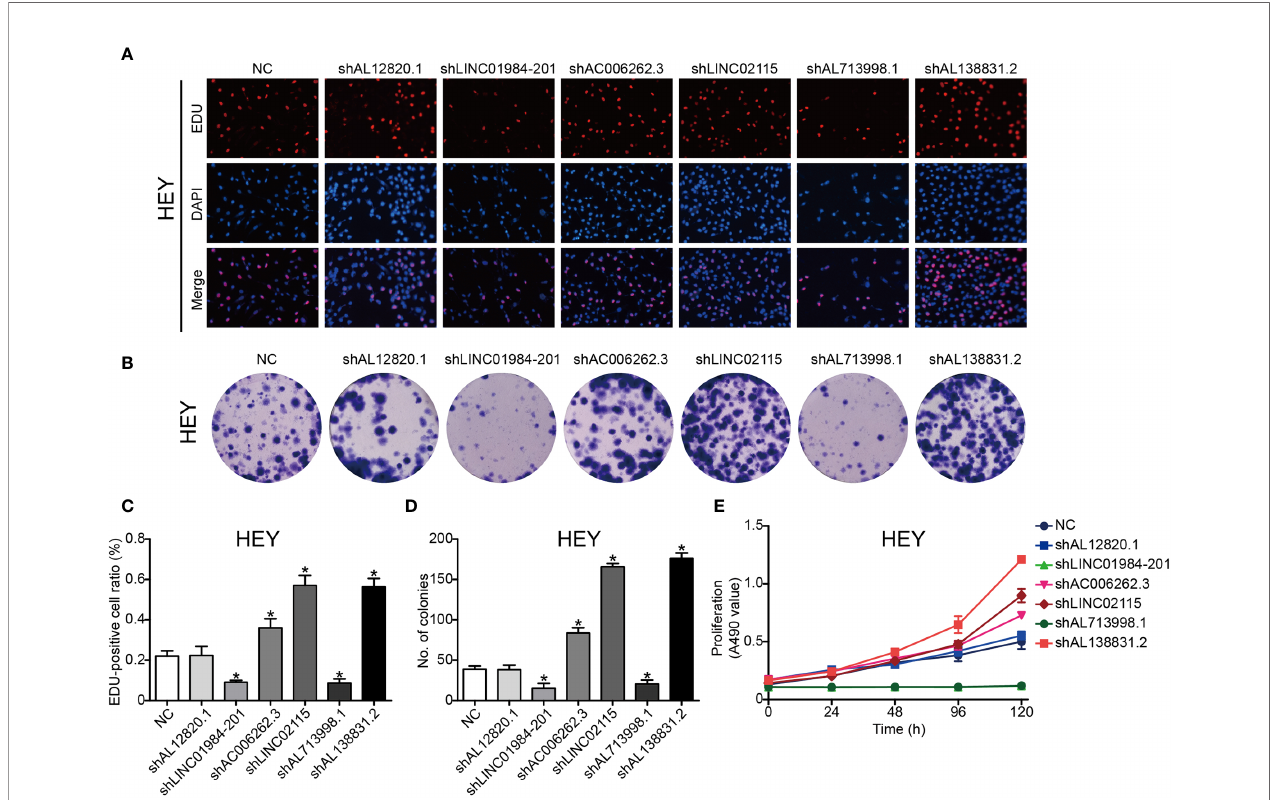
FIGURE 6 | LncRNAs regulated the proliferation ability of HEY cancer cell line. After knocking down of the LncRNAs, the proliferation ability of HEY cancer cells was detected by Edu staining, colony formation and CCK8 assay. (A) Representative images of EDU staining; (B) Representative images of colony formation; (C) The quanti fi cation result of EDU staining; (D) The quanti fi cation result of colony formation; (E) The cell viability inspected by CCK8 assay. P*<0.05 vs . NC. Data were from three independent